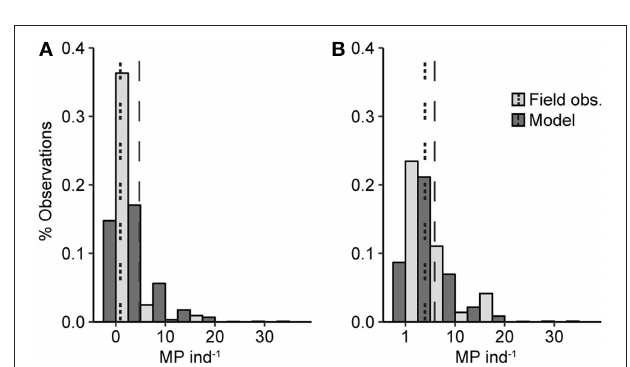
FIGURE 3 | Frequency distribution of the MP burden based on the model simulations (dark gray bars) and field observations (light gray bars). (A) shows the entire dataset and (B) presents only fish with MP in the GIT (i.e., the non-zero values). The dashed vertical lines indicate the mean values for the model simulations (long dash) and the observations (short